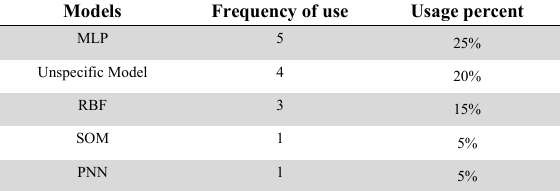
Comparison of the Artificial Neural Network models